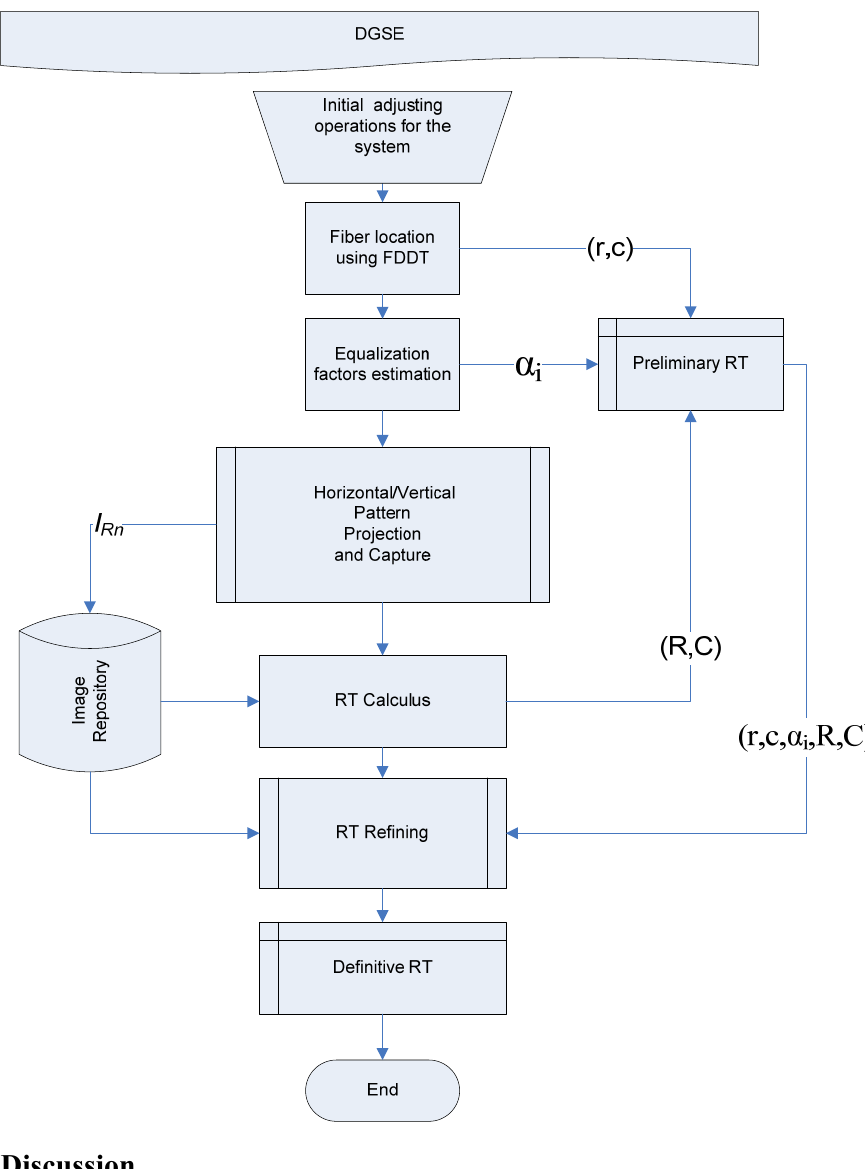
Figure 6. General procedure for